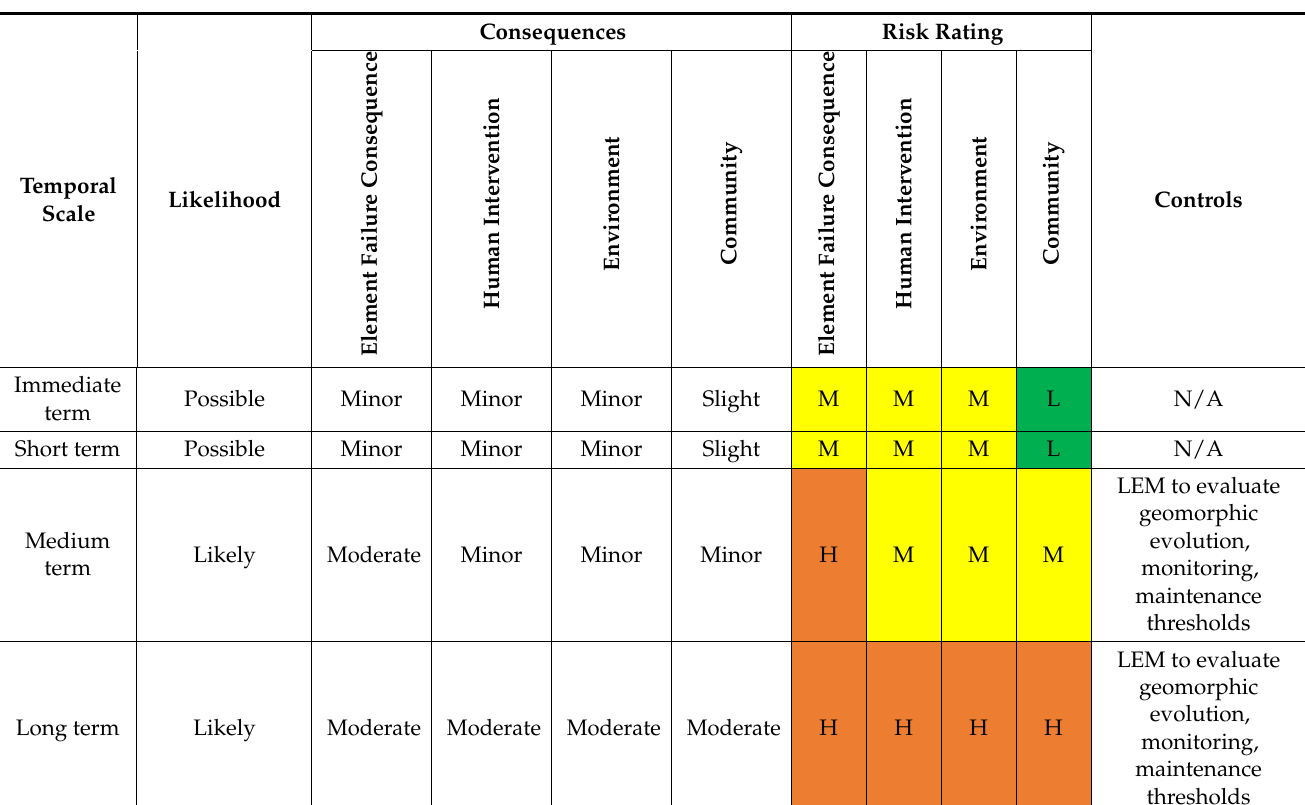
Table 7. Immediate-term, short-term, medium-term, and long-term risk assessments for surface erosion of the